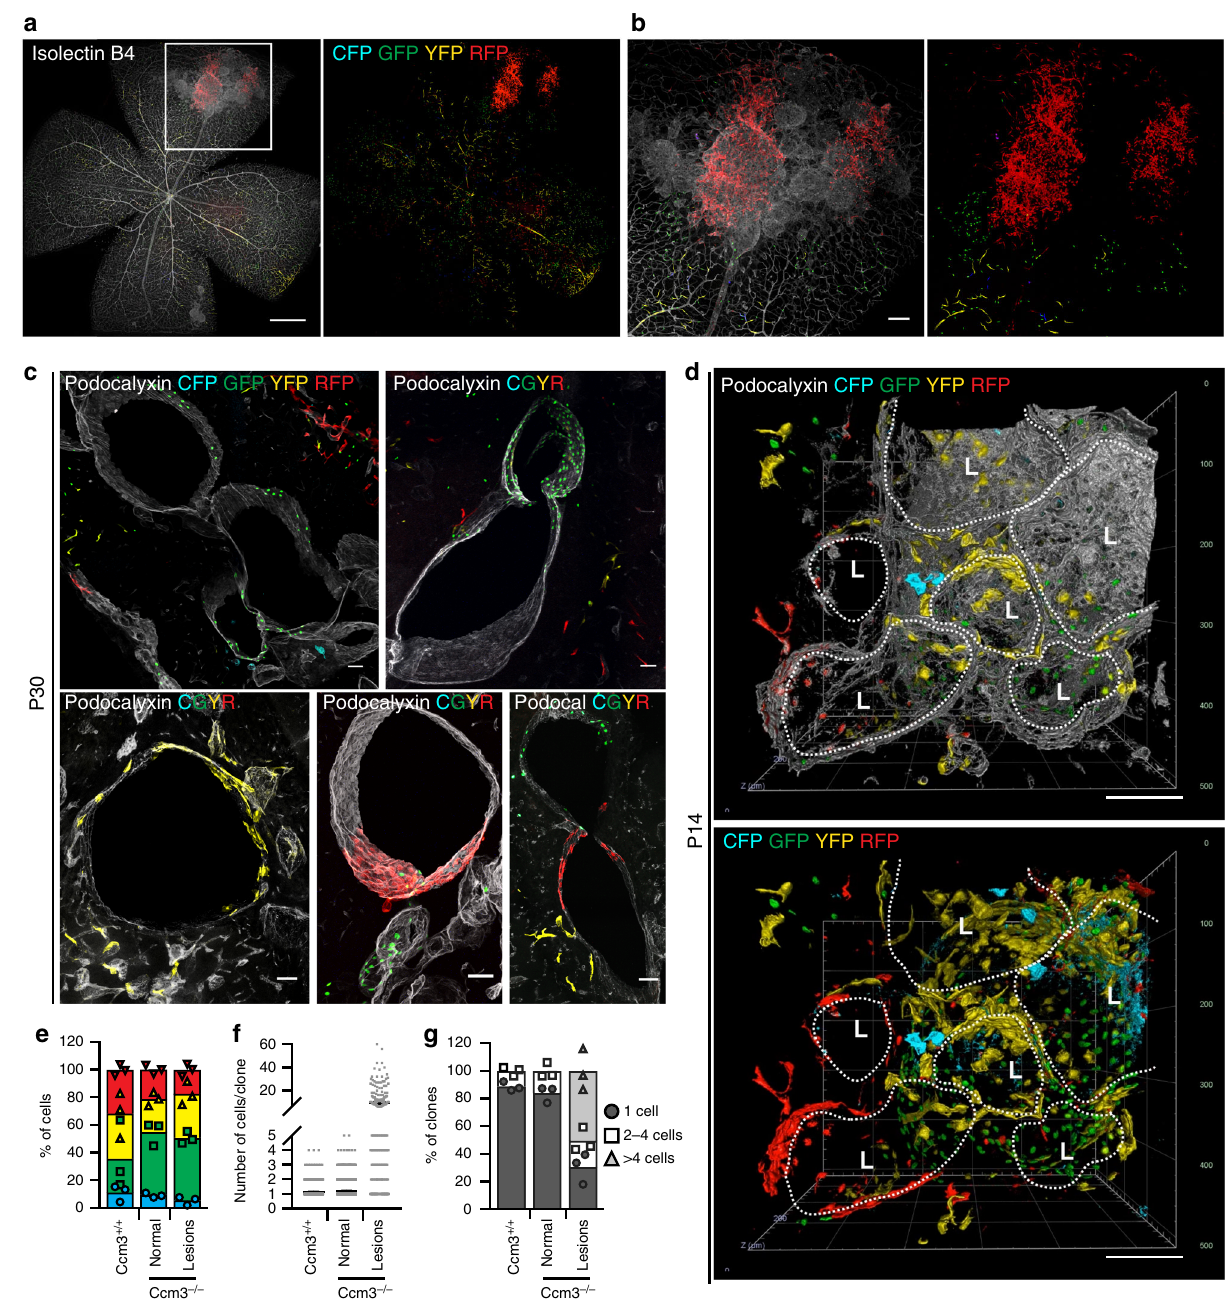
Fig. 3 Cavernomas are composed of clones of Ccm3 − / − cells that attract Ccm3 + / + cells. Representative images of retina ( a , b ) and cerebellum ( c ) from chronic Cdh5(PAC)- Cre-ER T2 / Ccm3 f/f /R26R- Confetti mice at P30. The vessels are counterstained with Isolectin B4 ( a , b ) or Podocalyxin ( c ) and are displayed as greyscale. d Three-dimensional reconstruction of mulberry cavernomas from P14 brain. The vessels are counterstained with Podocalyxin; L stands for Lumen. Scale bars, 500 μ m ( a ); 100 μ m ( b ); 50 μ m ( c ), 100 μ m ( d ). e – g Analysis of clones in normal vessels of Cdh5(PAC)- Cre-ER T2 /R26R- Confetti mice and normal vessels and lesions of Cdh5(PAC)- Cre-ER T2 / Ccm3 f/f /R26R- Confetti mice. e Distribution of the four fl uorophores among clones. Data are means ± SE; n = 3 mice in each group. f Quanti fi cation of the number of cells that compose each clone. Data are means ± SE; n = 3 mice in each group. g Distribution of clone size. Clones were divided according to the number of cells they are composed of; each dot represents an animal. A total of 2371 clones were analysed from 3 mice in each group. Source data are provided as a Source Data fi